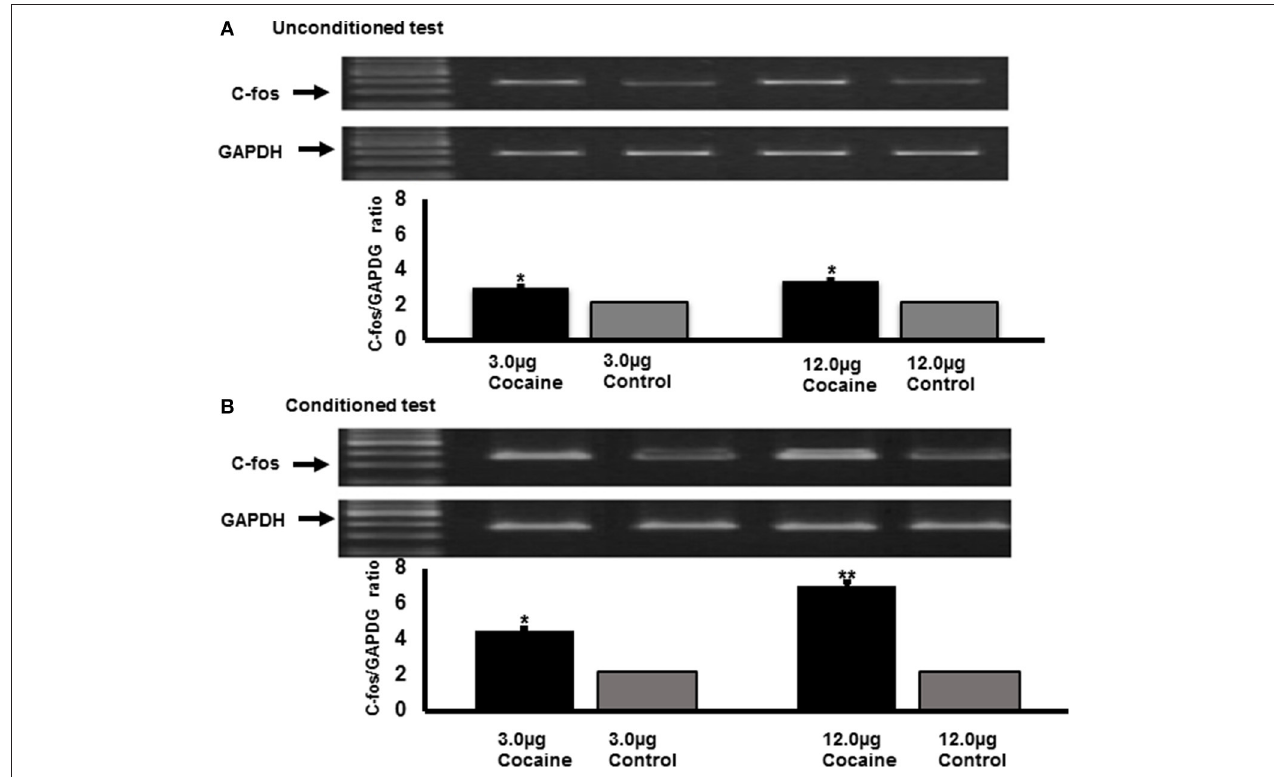
FIGURE 4 | C-Fos mRNA alterations in cocaine treated animals (3 and 12 µ g/g) in unconditioned (A) and conditioned environment (B) . The effect of cocaine on c-Fos mRNA expression was measured by quantitative RT-PCR (Top panel) and normalized with GAPDH (panel below). Data represent mean ± S.E.M. at 35min following CPP and non-conditioning after 5 days of cocaine injections ( n = 9). Different doses of cocaine (3 and 12 µ g/g) induced a significant [ F (3,23) = 62.05, P < 0.001] change in c-Fos mRNA expression in unconditioned treatment with cocaine when compared with the control animals without cocaine injection. The effects of 3 and 12 µ g/g doses of cocaine were not significantly different (3 µ g/g, * P < 0.05; 12 µ g/g, * P < 0.05). The conditioning effect of cocaine was significant [ F (3,27) = 92.12, P < 0.001] when compared with the control group. The expression of C-Fos mRNA was significantly higher at a higher dose of cocaine (12 µ g/g, ** P < 0.05) when compared with a lower dose (3 µ g/g, * P <